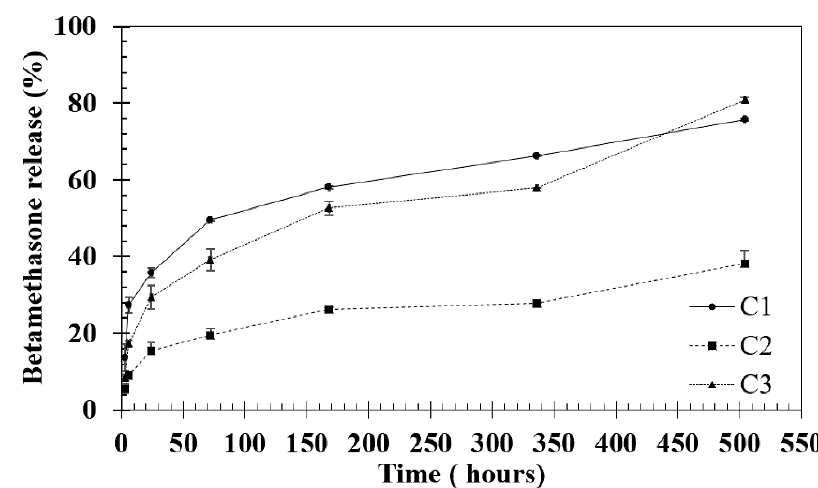
Figure 5. Percentage of betamethasone release from Ty–GG/SF hydrogels (C1, C2 and C3) for 1, 3, 24, 72, 168, 336 and 504 h.